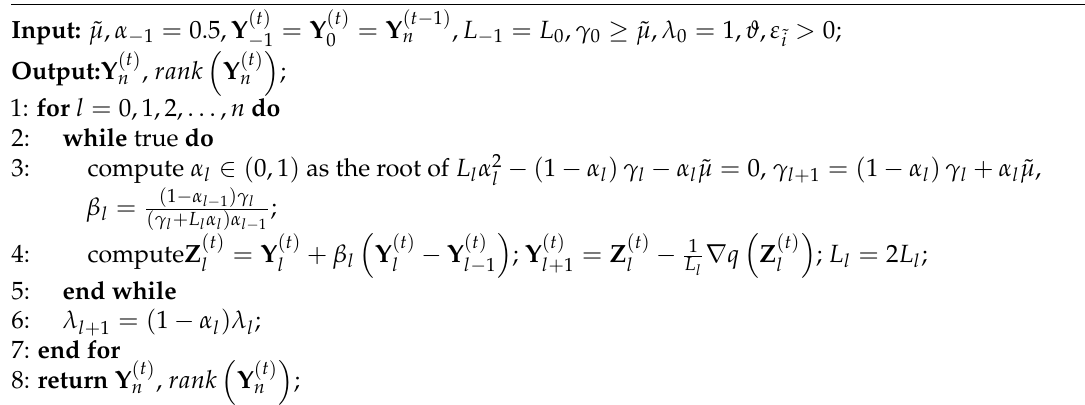
Algorithm 1 Accelerated Algorithm for Subproblem